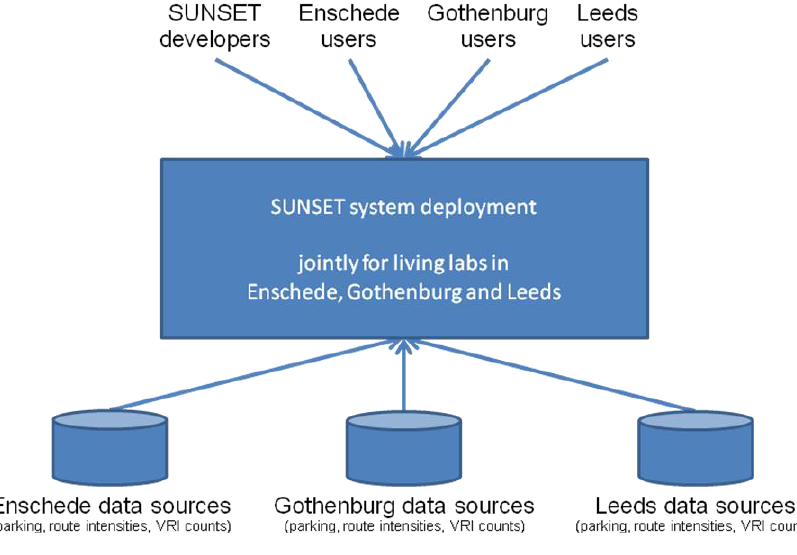
Figure 8. SUNSET deployment